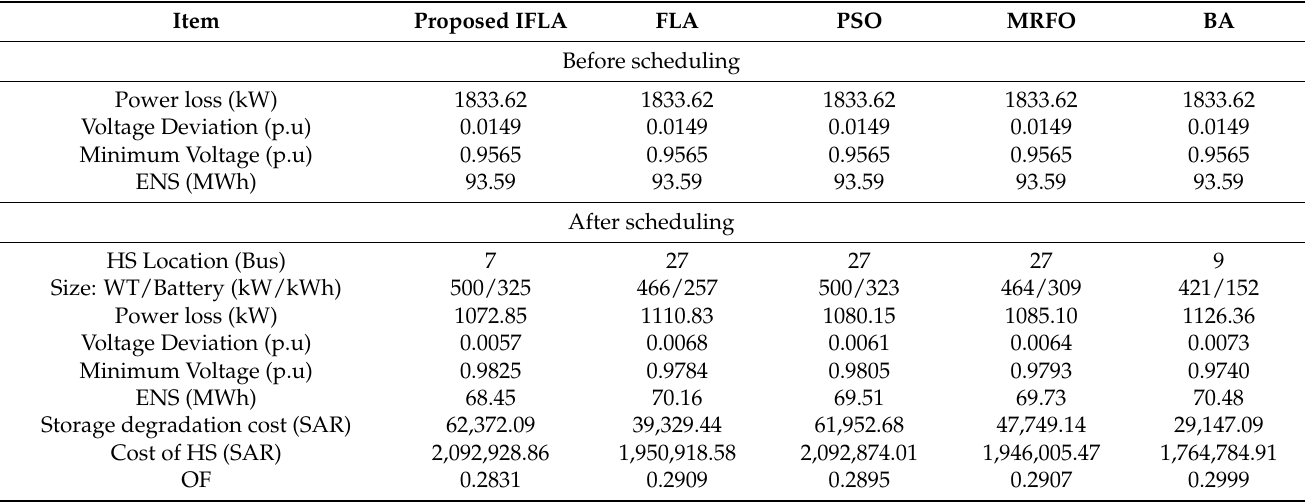
Table 7. The numerical report on different methods of hybrid WG/Battery system scheduling with storage degradation cost for 33-bus distribution system.